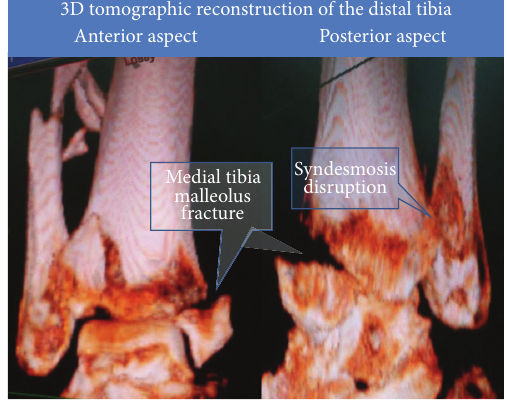
Figure 4: A pilon fracture with several major fragments is seen. The main fragment appears to be lateral accompanied by syndesmosis